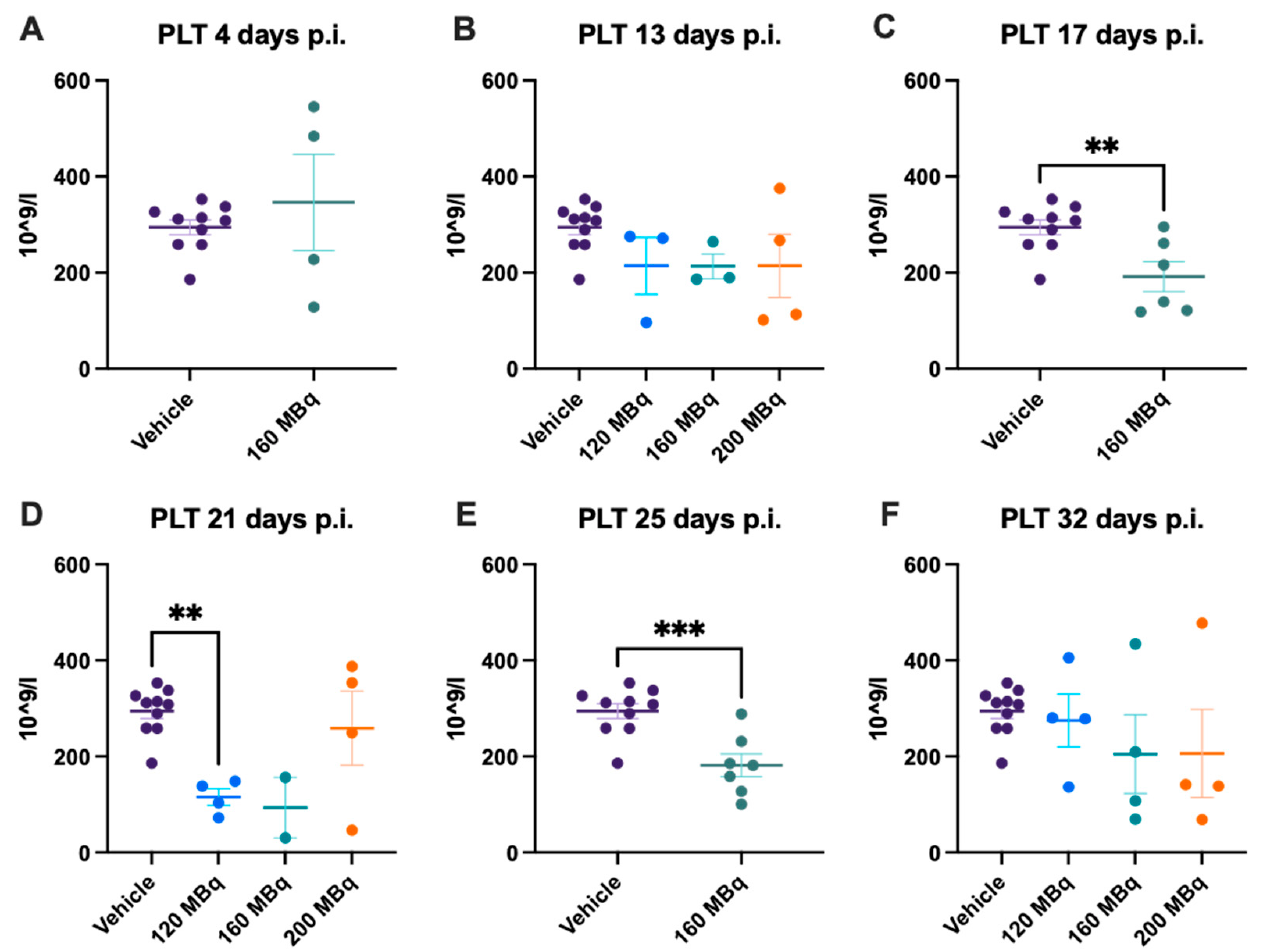
Figure 5. Platelet count after 4 ( A ), 13 ( B ), 17 ( C ), 21 ( D ), 25 ( E ), and 32 days post injection of 120 MBq ( B , D , F ), 160 MBq ( A – F ), or 200 MBq ( B , D , F ). Values are presented as individual plots with group mean ± SEM. Differences between groups were analyzed using an unpaired t -test ( A , C , E ) or one-way ANOVA with post-hoc Tukey ( B , D , F ). ** p < 0.01, *** p < 0.001.